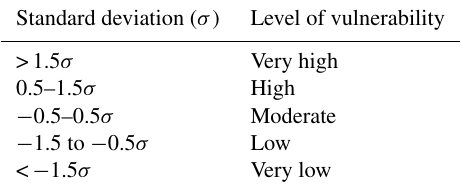
Table 2. Vulnerability level classification based on standard devia-